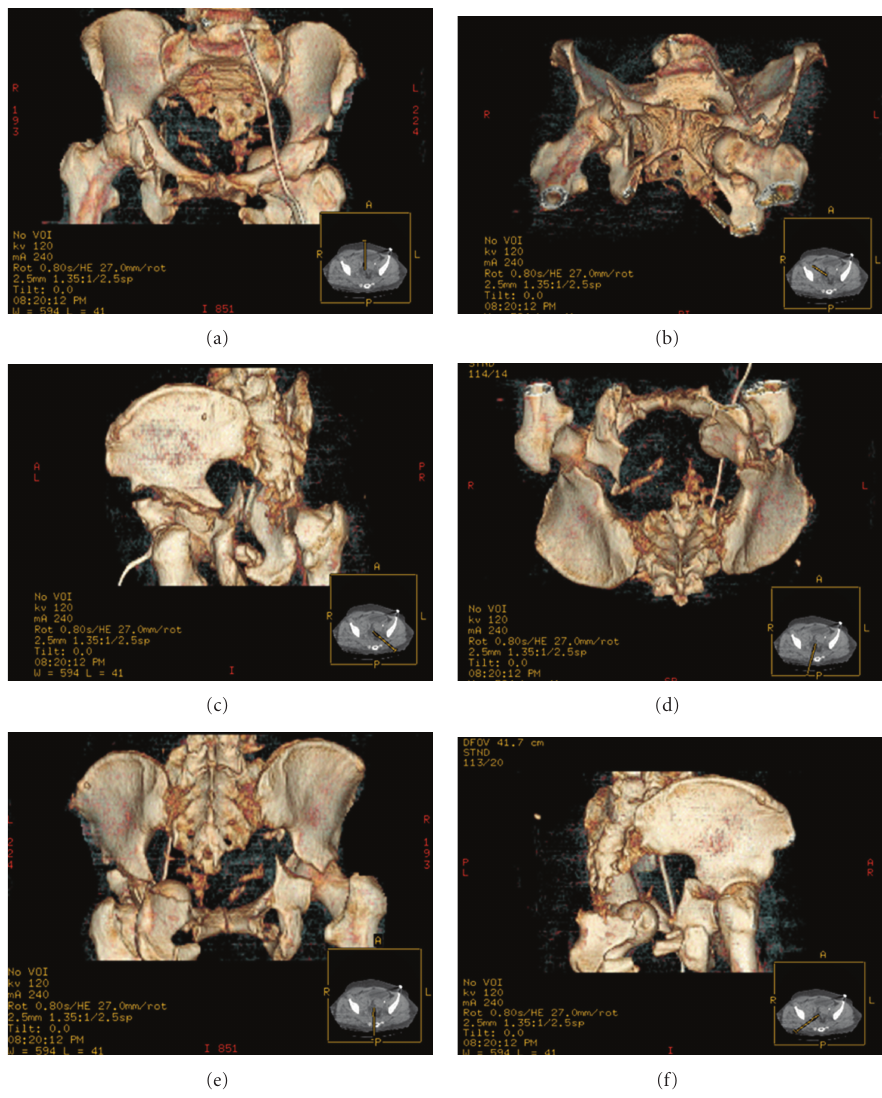
Figure 2: (a) 3D CT reconstruction of pelvis—courtesy of the Botsford General Hospital Radiology Department (anterior-posterior